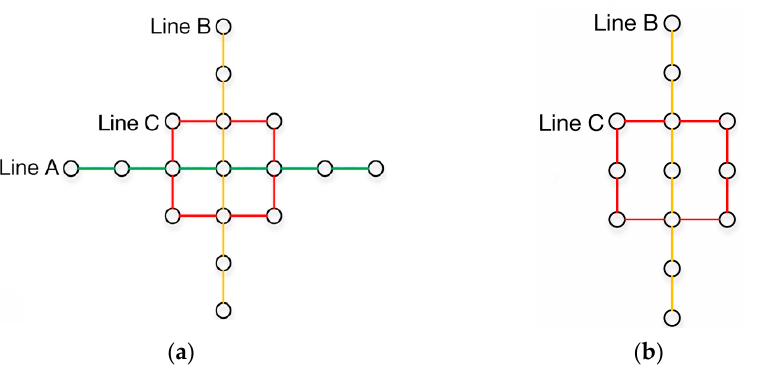
Figure 5. Deleting method of nodes connection after line shutdown. ( a ) Line A before shutdown. ( b ) Line A after shutdown. A subway network with A lines